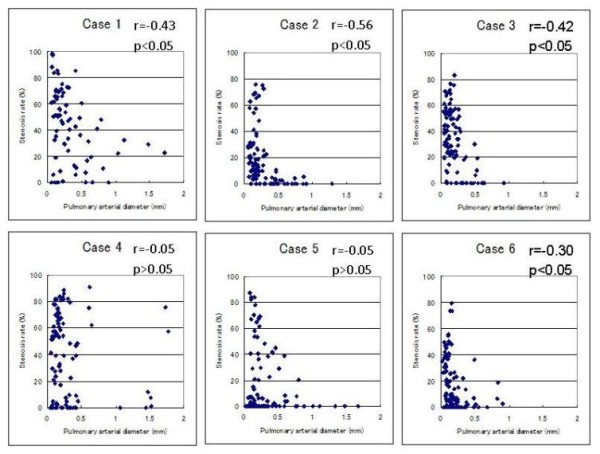
Scatter plots of pulmonary arterial diameter and stenosis rate in pulmonary arteries. There was a significant negative association between pulmonary arterial diameter and stenosis rate in four of the six cases (Case 1, 2, 3, and 6). In contrast, there was no significant association in the remaining two cases (Case 4 and 5).